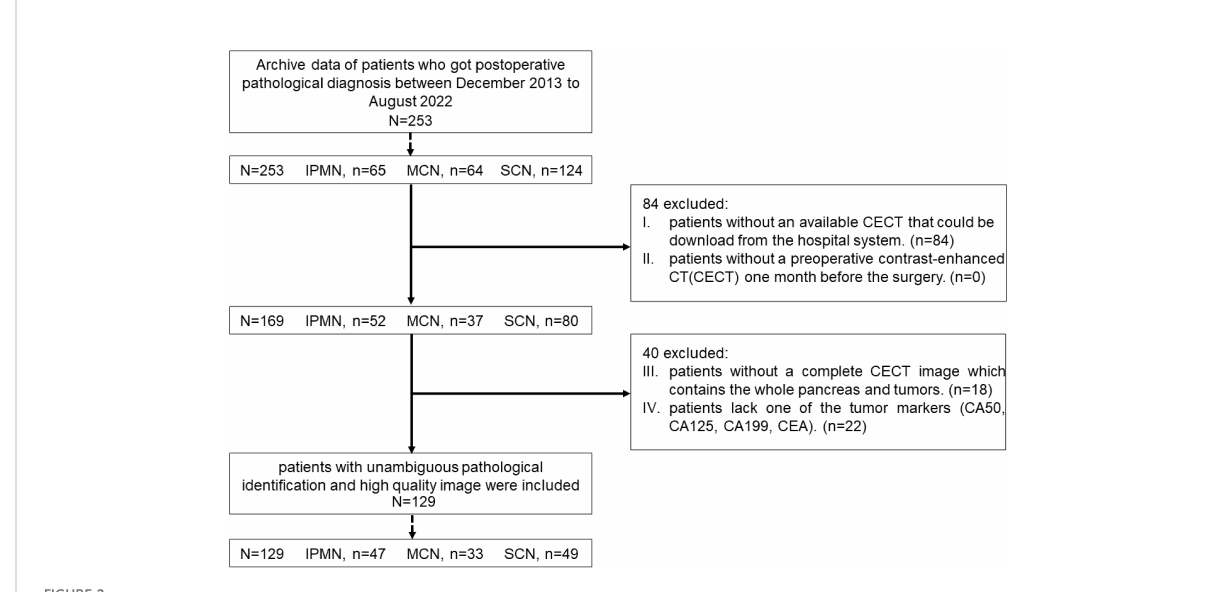
FIGURE 2 Patients ’ enrolment process for this